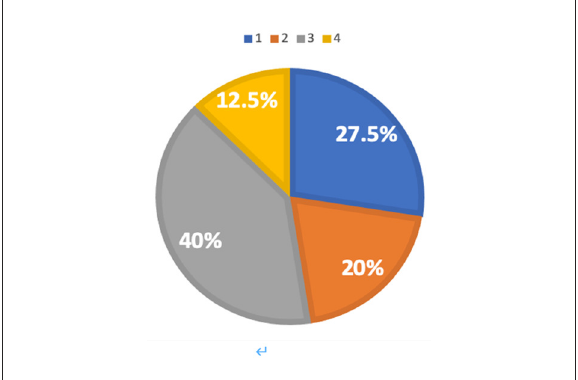
FIGURE9 Profile membership of L1 Mandarin speakers rated